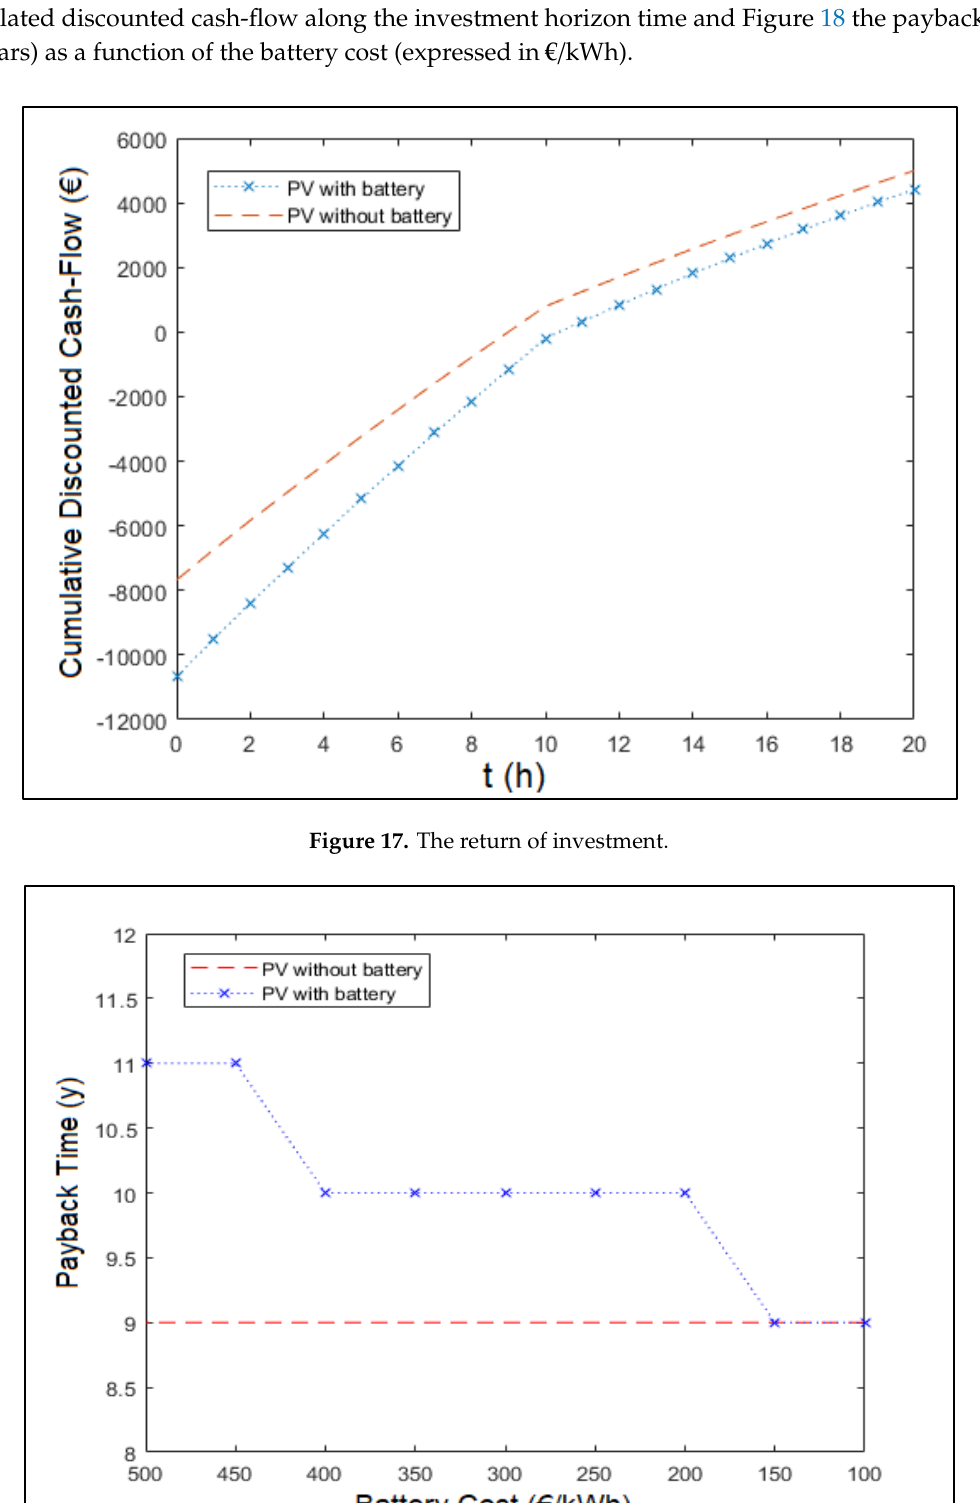
Figure 18. Payback time sensitivity analysis depending on the variation of the battery cost.